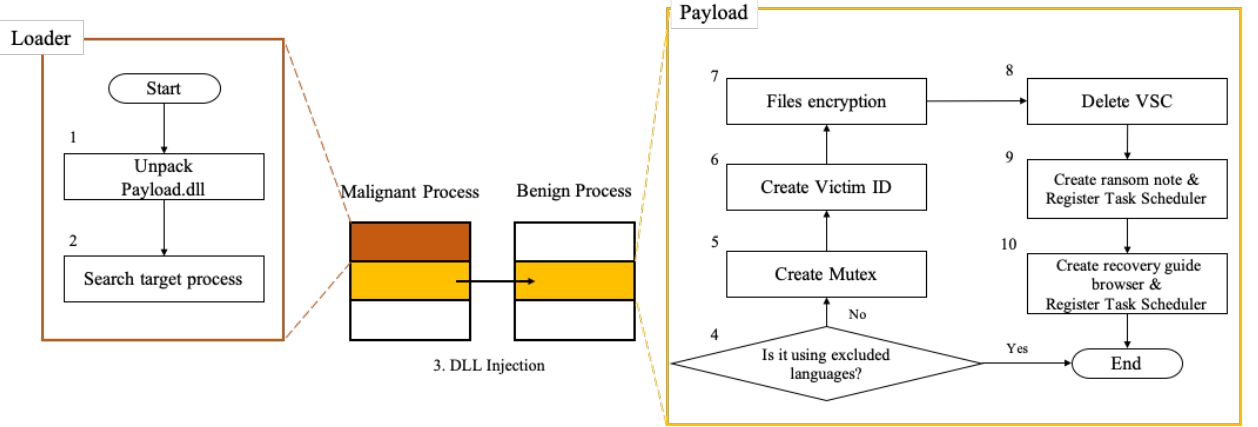
Figure 1. Entire process of malicious behavior by Magniber